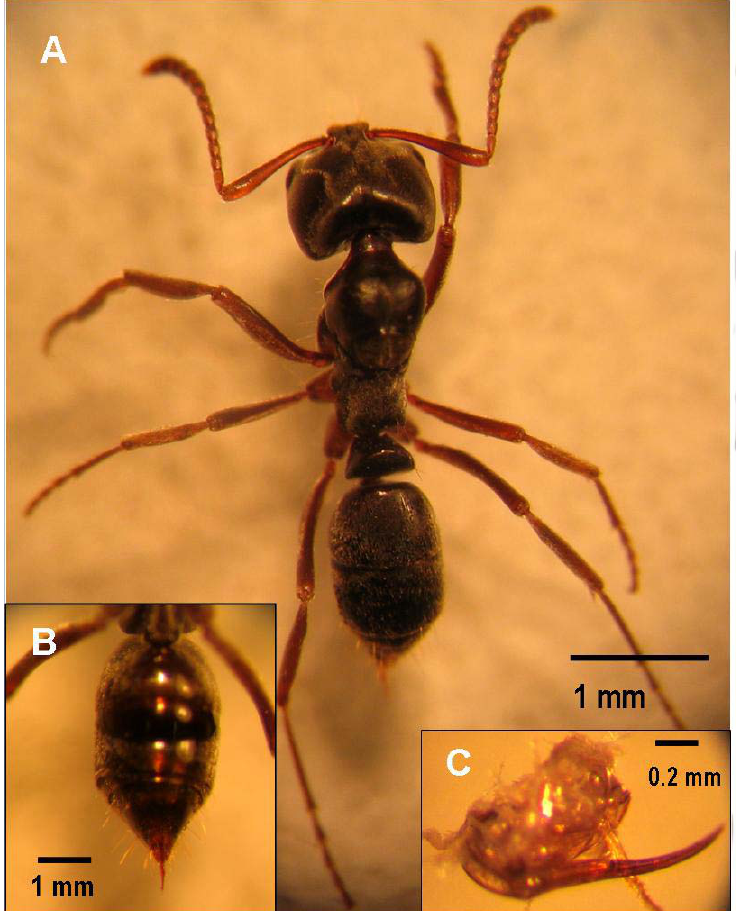
Figure 2. The Iranian Samsum ant P. sennaarensis : ( A ) worker, ( B ) the posterior abdominal sting and ( C ) the sting apparatus attached to the abdominal gland